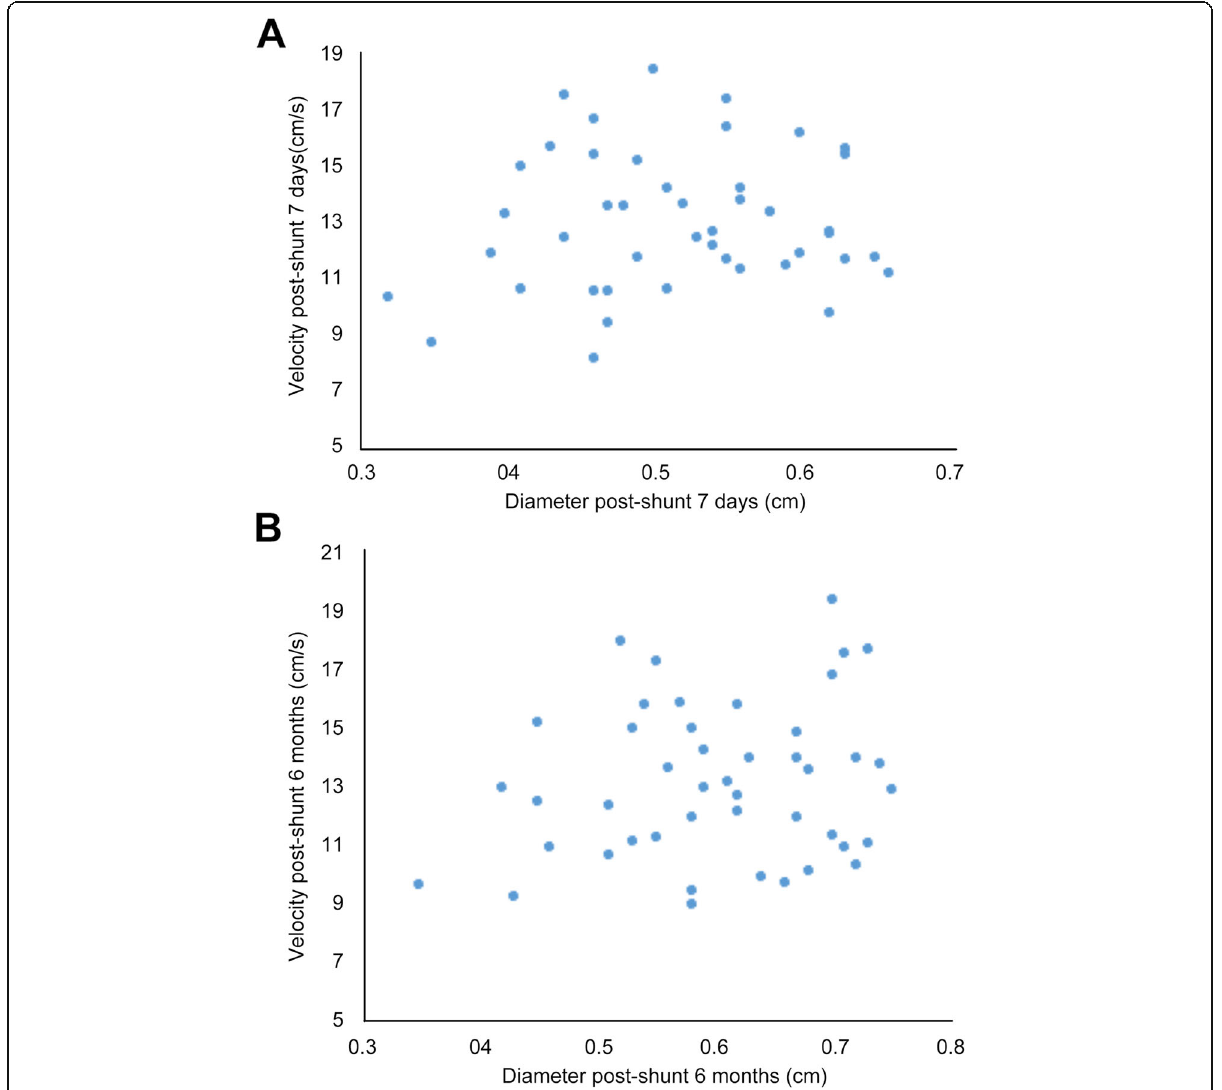
Fig. 4 Distribution map of bypass diameter and flow velocity in Group A at 7 days ( a ) and 6 months ( b ) after Rex-bypass shunt